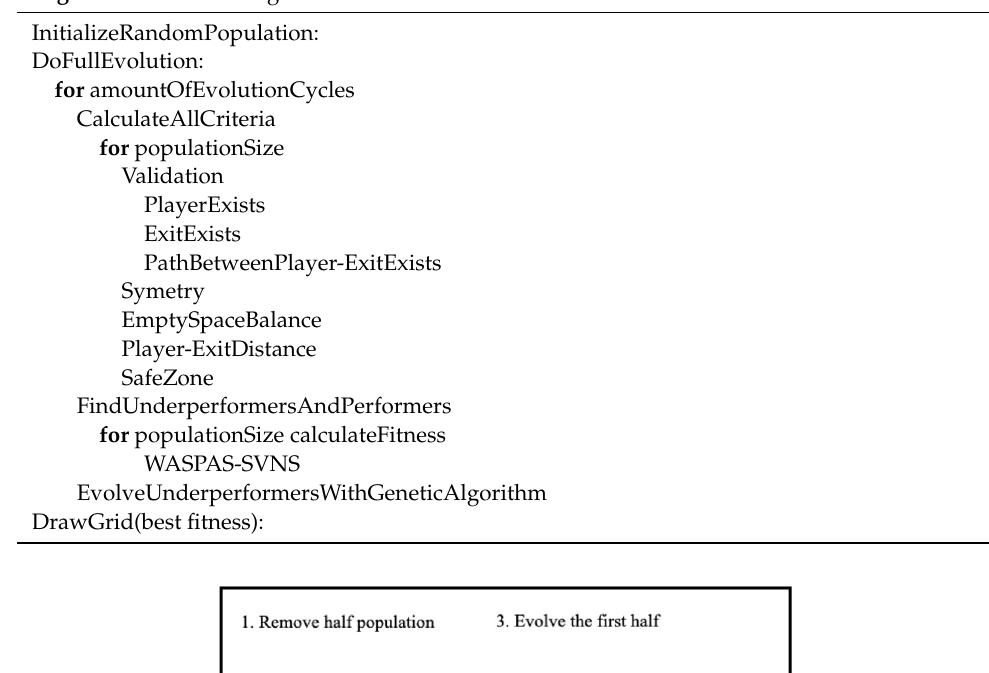
Algorithm 1. Genetic algorithm.